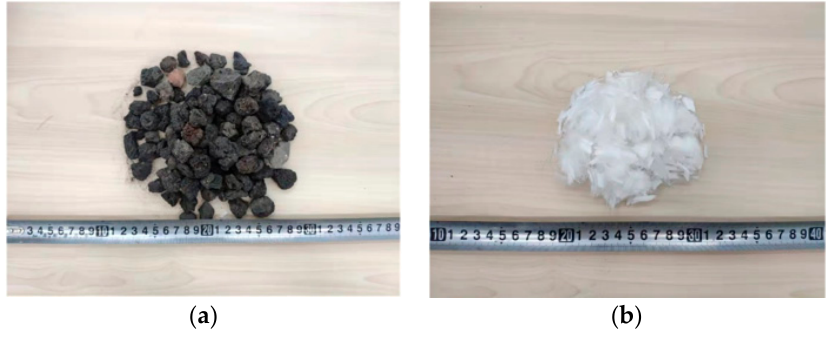
Figure 1. Materials: ( a ) Scoria aggregate, ( b ) PP fiber.